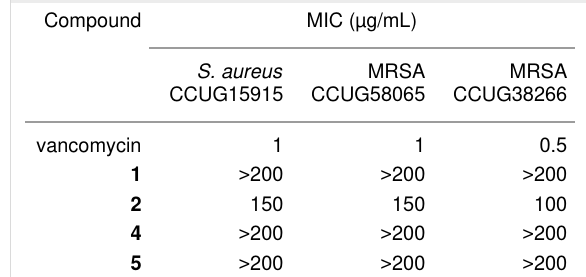
Table 1: Minimum inhibitory concentrations (MIC) of compounds 1 , 2 , 4 and 5 against S. aureus and two strains of